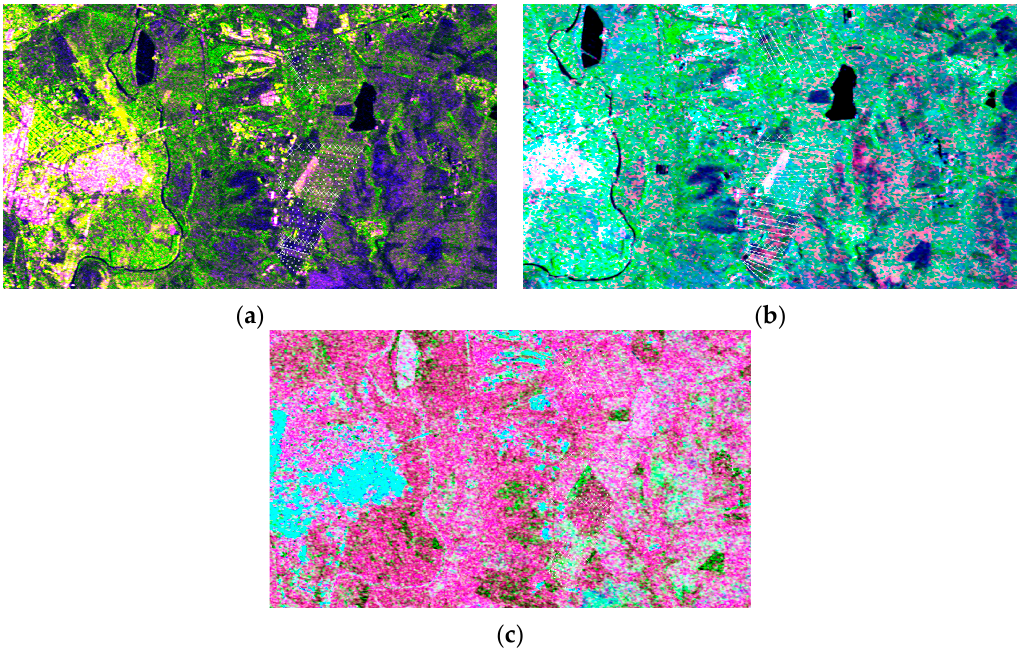
Figure 11. Radarsat-2 data from derived 10 June 2015 after ( a ) standard sigma backscattering technique; ( b ) Freeman–Durden; and ( c ) H/A/ α models.